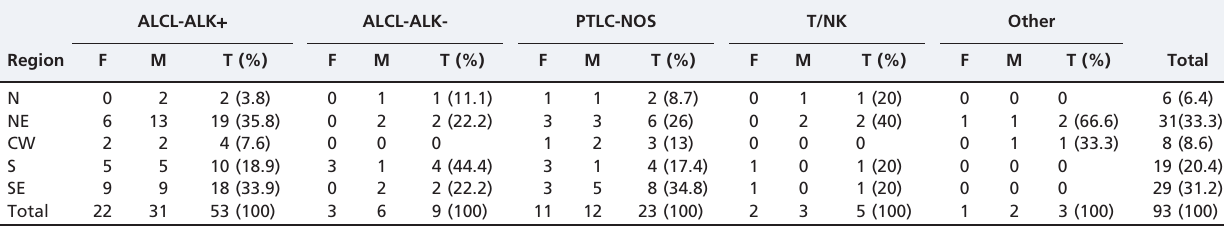
Table 5 - Geographic distribution of mature T-cell lymphomas in pediatric patients ALCL-ALK +